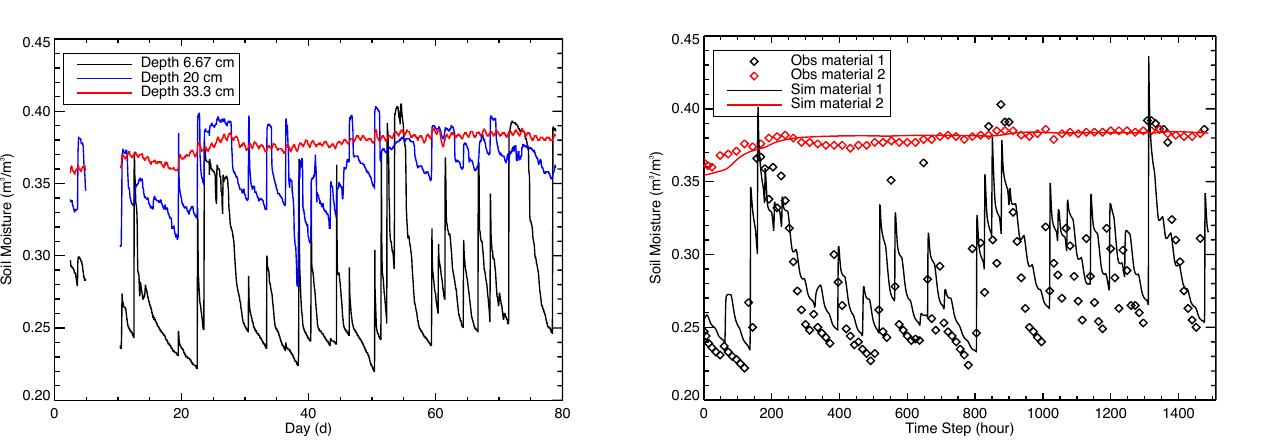
Fig. 3. Soil moisture data measured in the lysimeter from 16 November to 31 January (depth 13.3 and 26.6cm results are not plotted in order to make a readable graph).